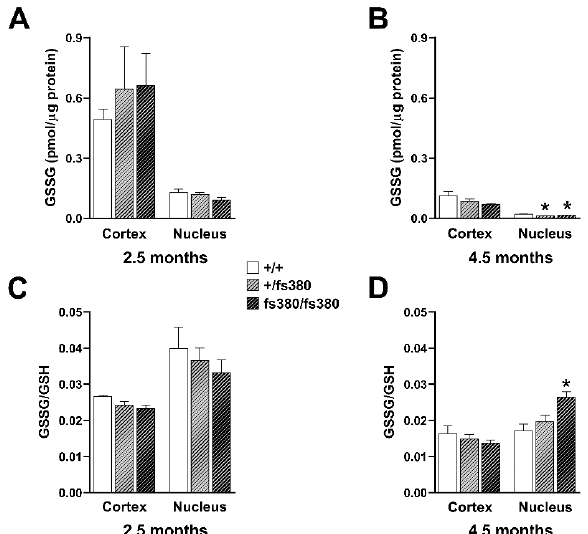
Figure 6. GSSG levels and GSSG / GSH ratio in the cortex and nucleus of Cx46fs380 lenses. ( A , B ) Graphs show the GSSG levels in the lens cortex and nucleus from wild-type ( +/+ ) and heterozygous ( +/ fs380) and homozygous (fs380 / fs380) Cx46fs380 mice at 2.5 ( A ) and 4.5 ( B ) months of age. ( C , D ) Graphs show the GSSG / GSH ratio in the lens cortex and nucleus from wild-type ( +/+ ) and heterozygous ( +/ fs380) and homozygous (fs380 / fs380) Cx46fs380 mice at 2.5 ( C ) and 4.5 ( D ) months of age. Data are presented as the mean (bar) + standard error of the mean (n = 3 for 2.5-month-old Cx46fs380 mice and n = 4 for 4.5-month-old Cx46fs380 mice). Asterisk denote a significant di ff erence compared with wild type ( p < 0.05). GSSG levels in homozygous Cx46fs380 lenses were not significantly di ff erent from wild-type in the cortex at 2.5 months and 4.5 months of age ( p = 0.54 and p = 0.09, respectively), nor did they di ff er in the nucleus at 2.5 months of age ( p = 0.14). The GSSG / GSH ratio in homozygous Cx46fs380 lenses was not significantly di ff erent from wild-type in the cortex at 2.5 months and 4.5 months of age ( p = 0.07 and p = 0.18, respectively), nor did they di ff er in the nucleus at 2.5 months of age ( p = 0.45).